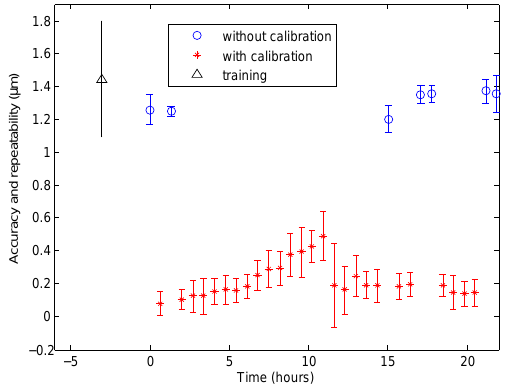
Figure 17. Experimental accuracy and repeatability of 2-DoF nanopositioning stage in training and validation phases. Time 0 = end of training = start of validation.